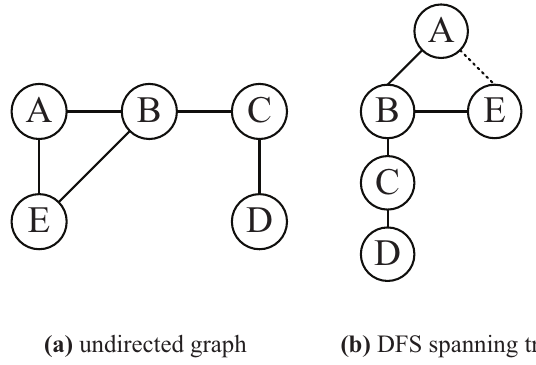
Figure 3. Depth-first search (DFS) spanning tree of an undirected graph, ( a ) an undirected graph; ( b ) a DFS spanning tree accessed from node